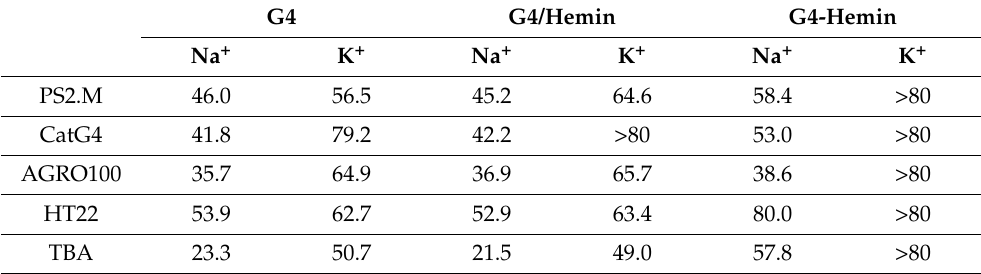
Table 2. Melting temperatures of studied oligonucleotides in the presence of potassium or sodium cations measured using CD technique 1 .